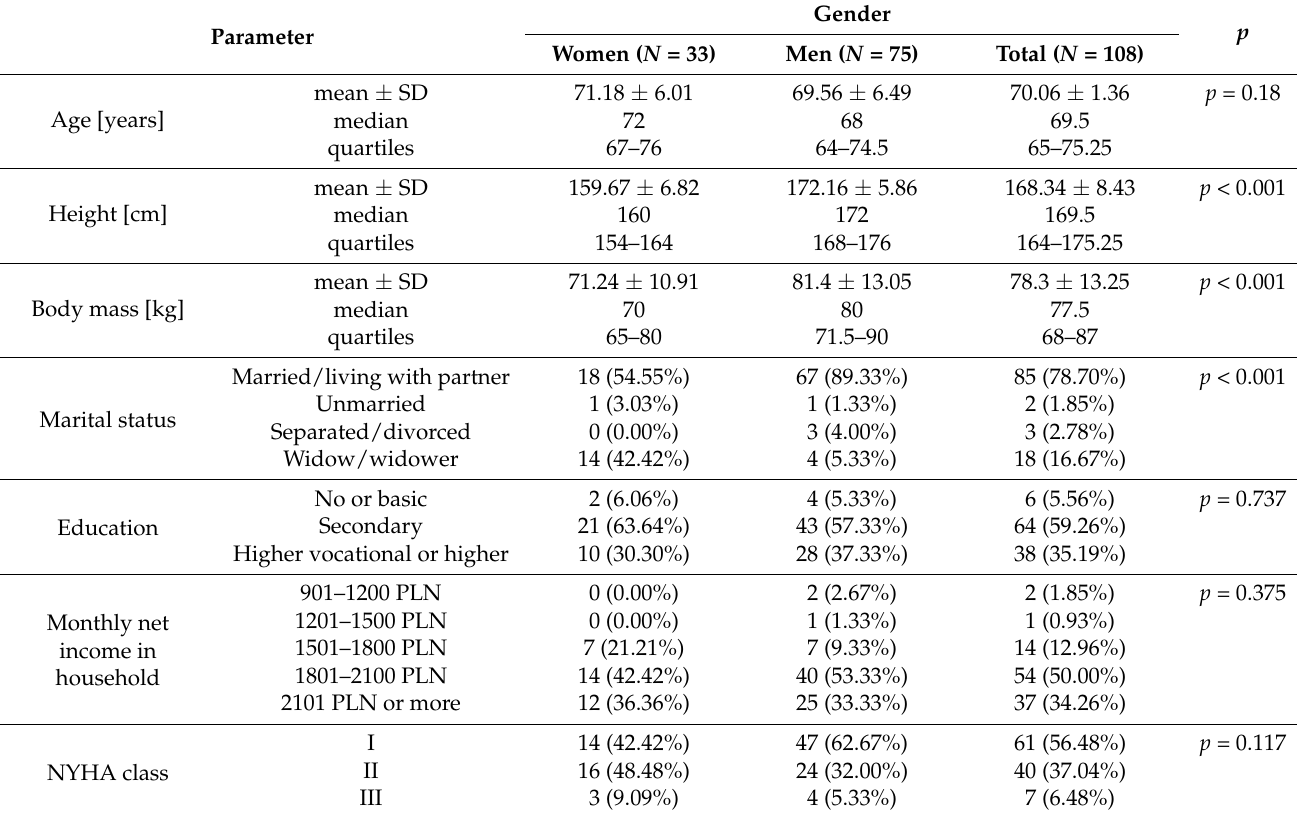
Table 1. Sociodemographic data of patients included in the study.